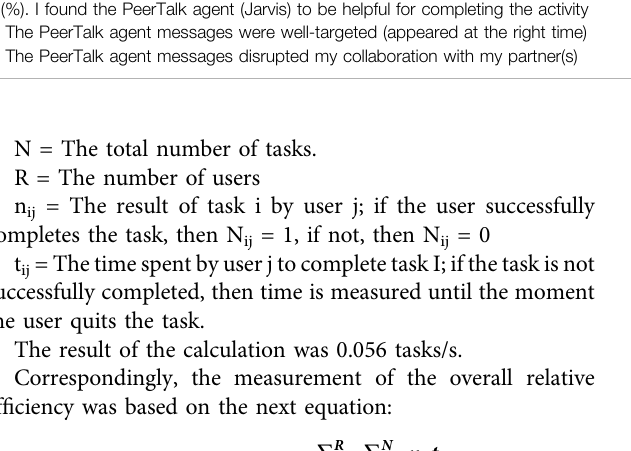
TABLE 2 | The results of the questionnaire regarding how the students perceived the agent presence. Questionnaire item (1-disagree,